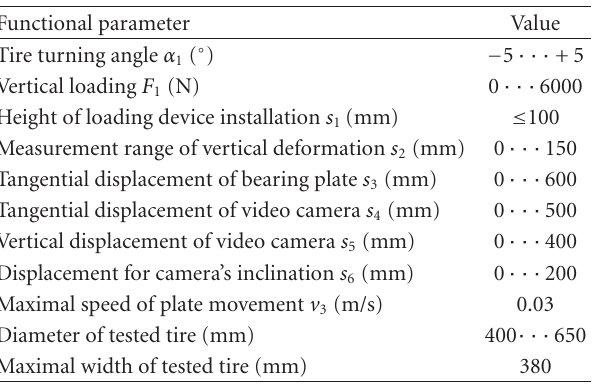
Table 1: Technical data of tire test